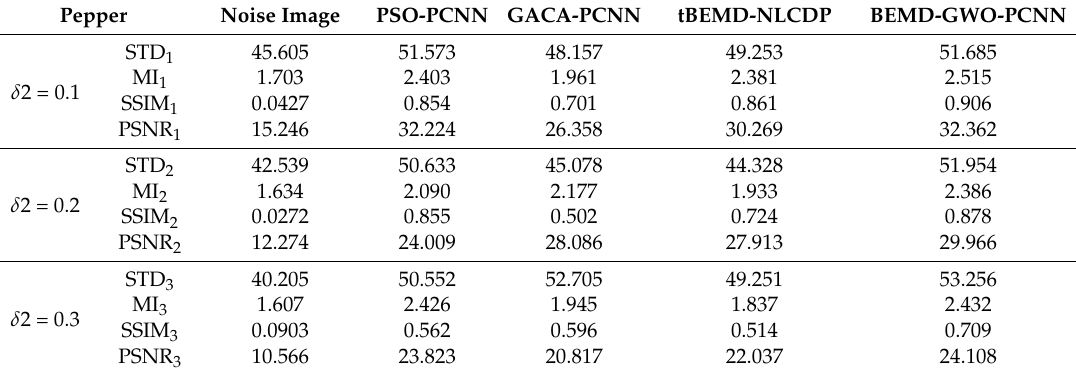
Table 5. Comparison of the adaptive PCNN combined with BEMD method with other current denoising methods corresponding to different noise intensity values δ in